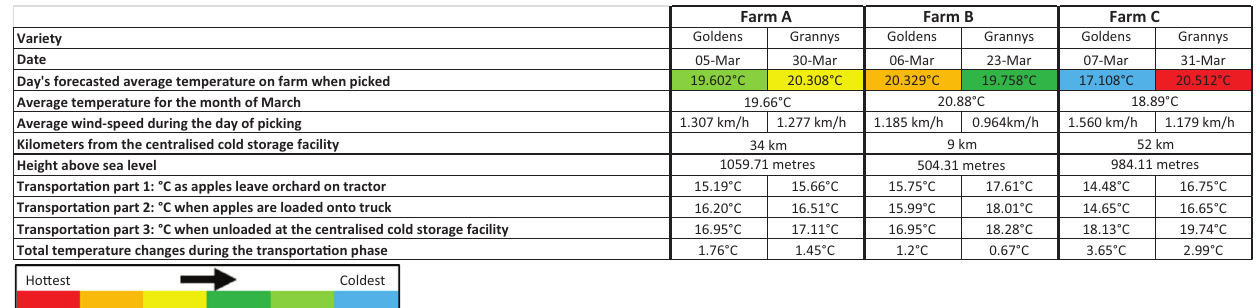
FIGURE 4: Geographical information on picking day for Farm A, Farm B and Farm